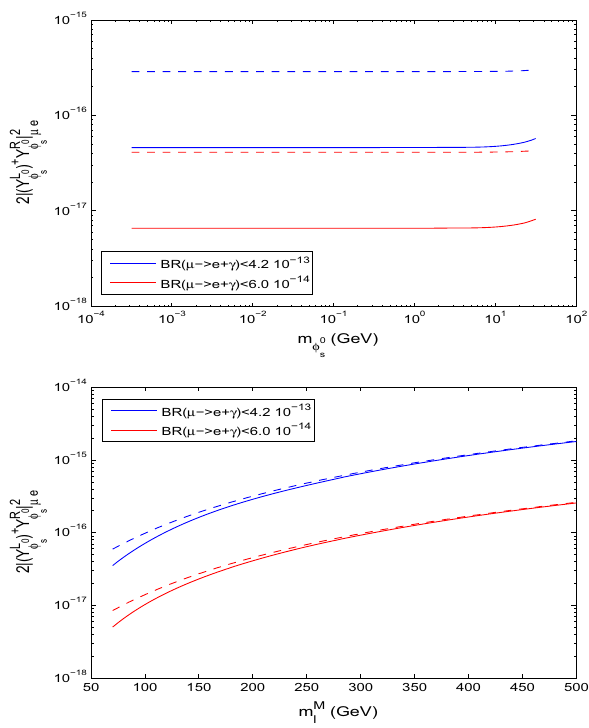
) † Y R | 2 μ e upper limits by the current φ 0 0 s s